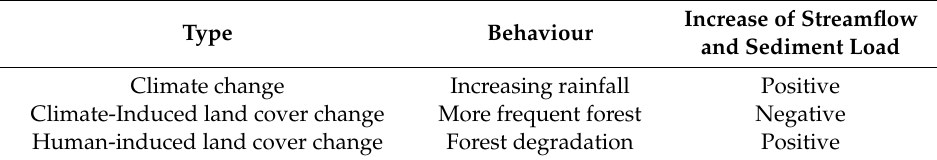
Table 8. Environmental changes and their